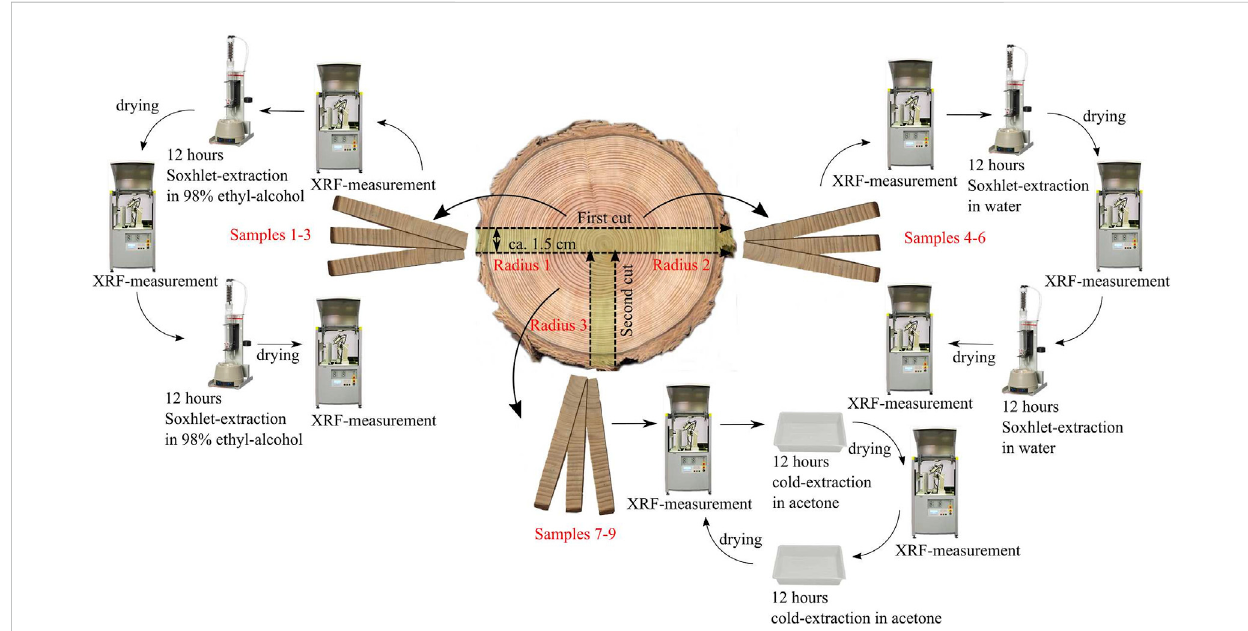
FIGURE 1 Sample preparationand analysis steps: Three wood blocks from three differentradii of one stem disc were prepared and three 1.2 mm thick sample stripes were cut, resulting in a total of nine samples per tree species/wood-type. Itrax measurements were done prior to extraction and after each extraction round in the three solvents alcohol, water and